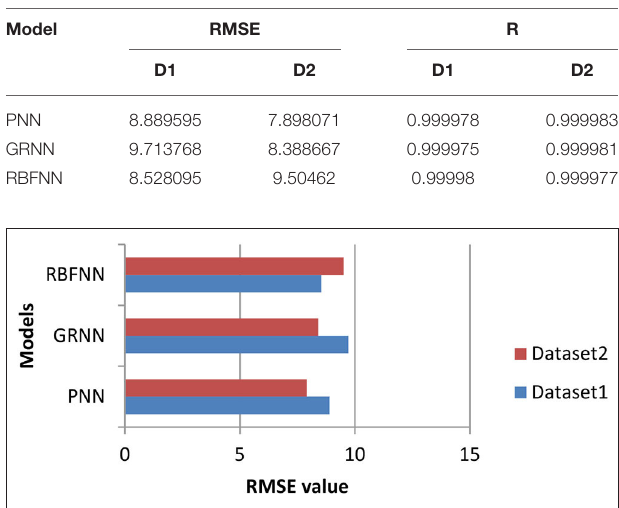
FIGURE 3 | Comparison of RMSE values with a different model.